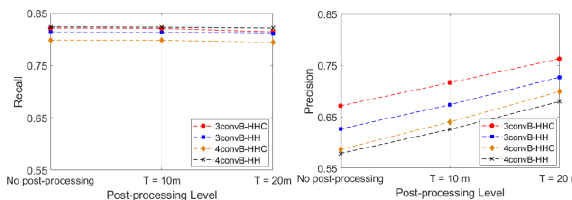
Figure 5. Recall and precision of different models with different post-processing levels. (a) Recall vs. post-processing level. (b) Precision vs. post-processing level. Four curves represent four different